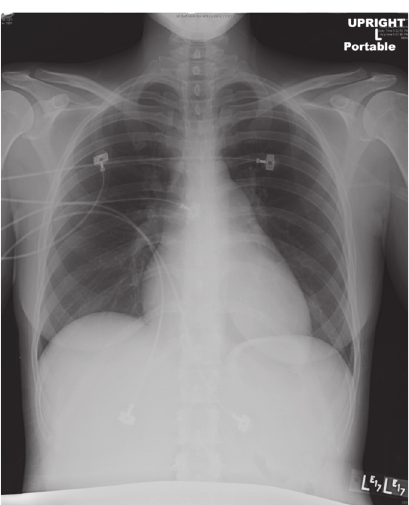
Figure 1: Initial chest X-ray showed no acute findings.